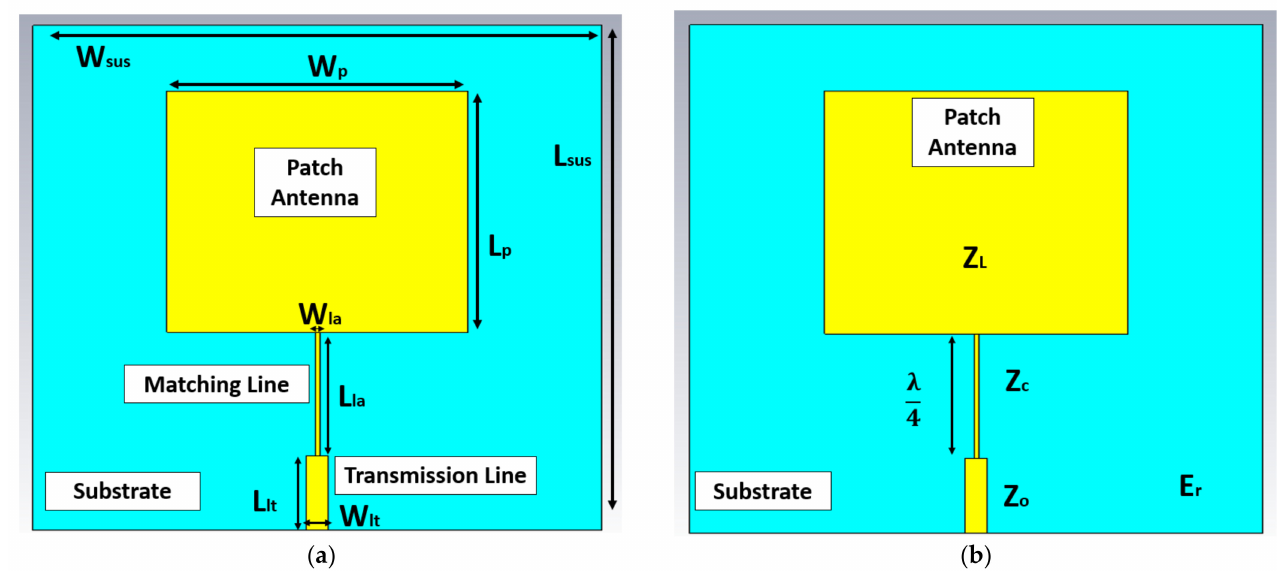
Figure 6. Both figures are microstrip feed with a quarter wavelength transmission line. ( a ) details of the sizing parameters, and ( b ) impedances.